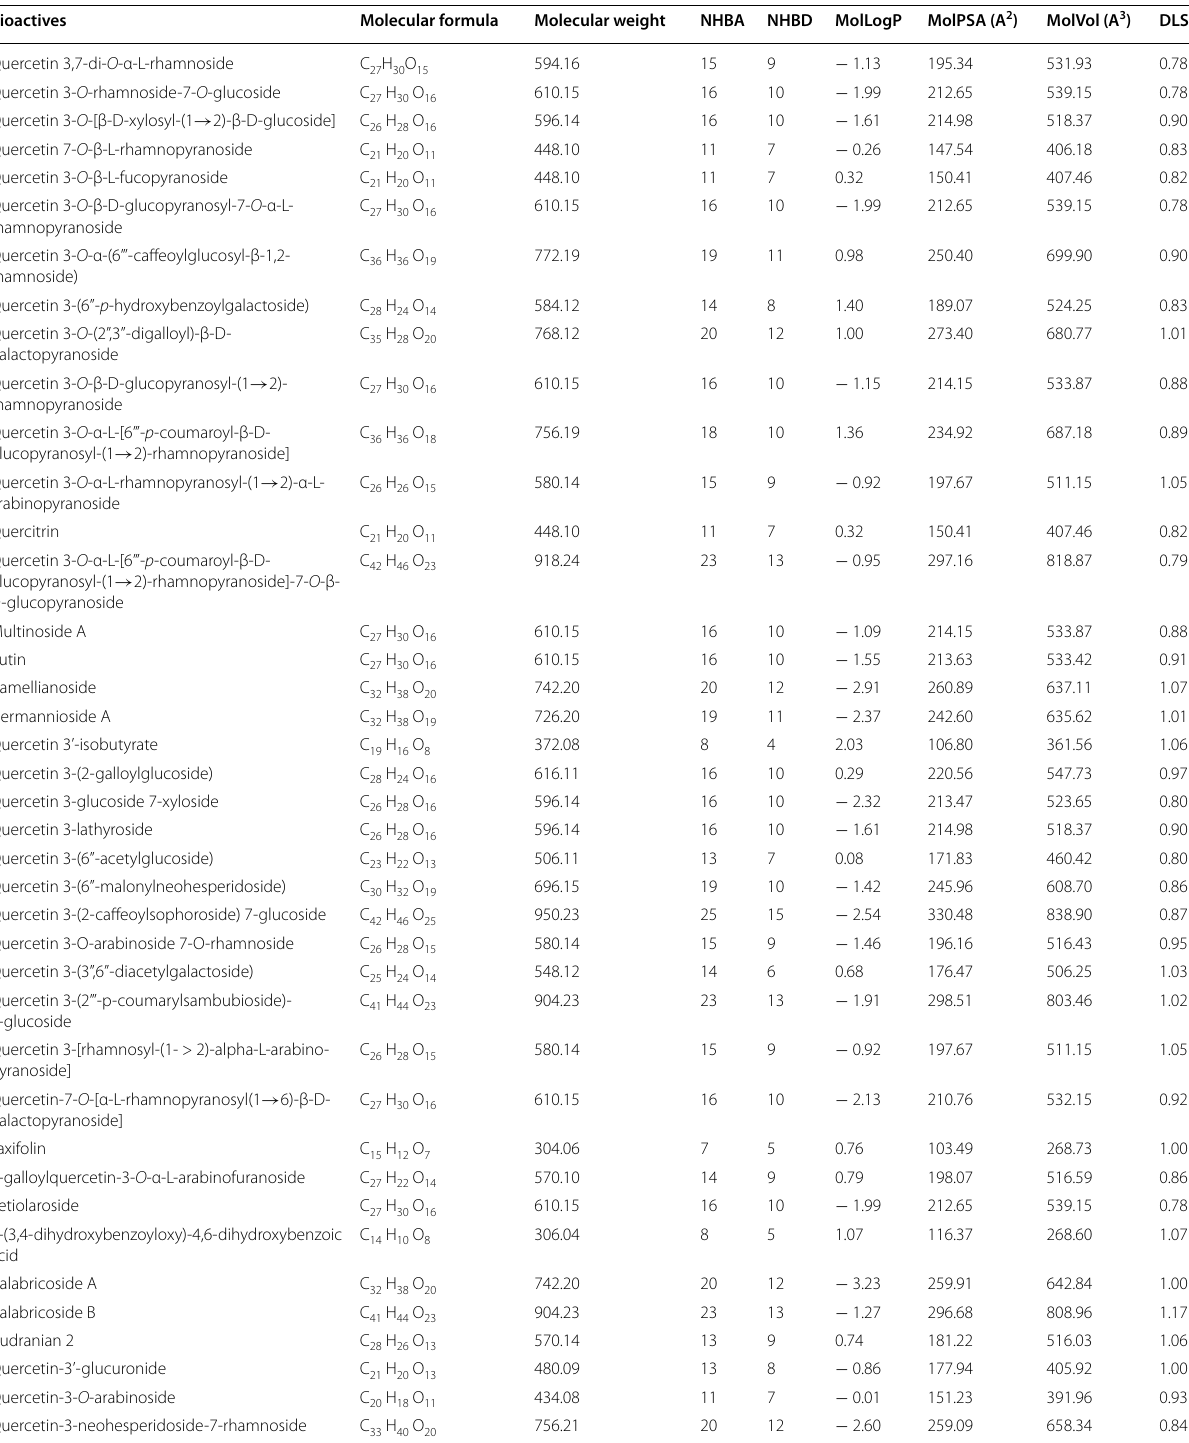
Table 1 Druglikeness of quercetin derivatives with high positive